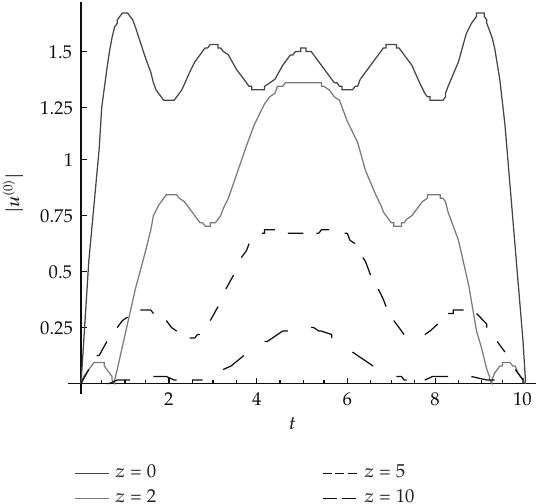
Figure 11: The zero-order approximation | u (cid:3) 0 (cid:4) | at α (cid:8) 1, T (cid:8) 10, γ (cid:8) 02 for di ff erent values of z , considering only one term in the series (cid:3) M (cid:8) 1 (cid:4) .